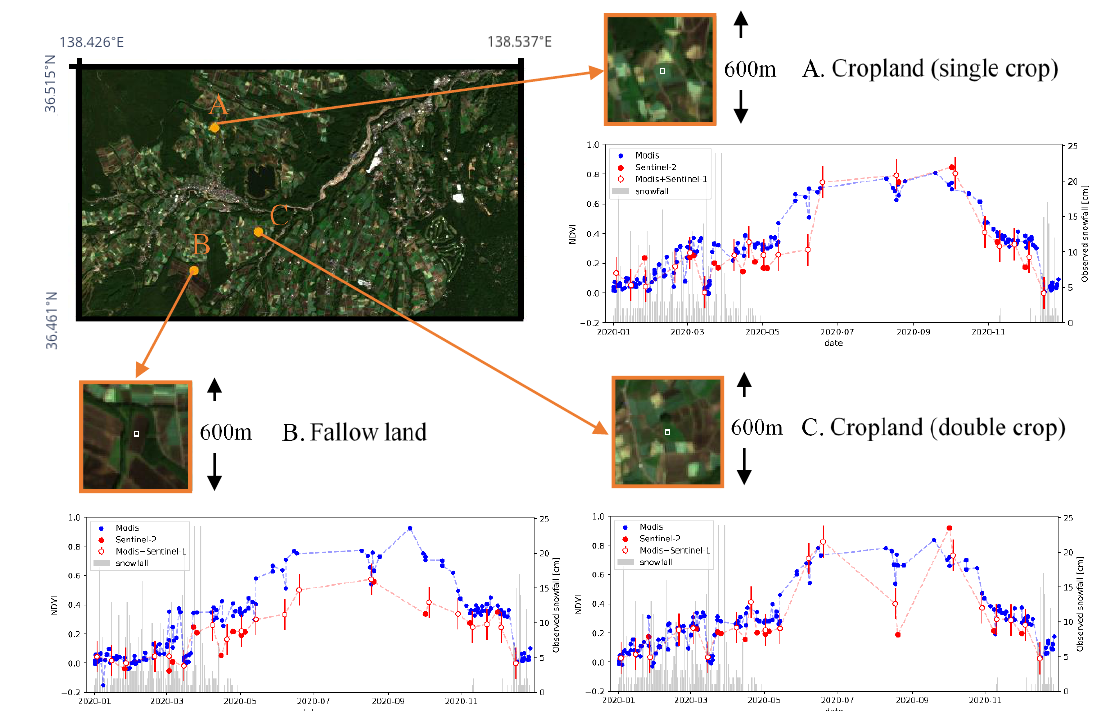
Figure 11. Time series plot of NDVI by original MODIS data and the combination of Sentinel-2 and MODIS+Sentinel-1 prediction. Image in upper-left shows view of the Tsumagoi area in 5 October 2020 acquired from Sentinel-2. Three points with different land usages were extracted. Three panels with orange frames shows zoomed image for the selected locations. The average value of the center 3 × 3 pixels, shown in white square inside each panel, is used as the estimated NDVI. The plot shows the transition of NDVI values. Blue plots represent the MODIS 250-m NDVI data and red plots show 10-m NDVI from the combination of Sentinel-2 NDVI and estimated NDVI from MODIS and Sentinel-1 by the proposed model. Outlined red plots represent estimation from the proposed model with error bars representing average MAE values evaluated in section 4.2.4. Gray bars show the amount of snowfall observed at Kusatsu Observatory.